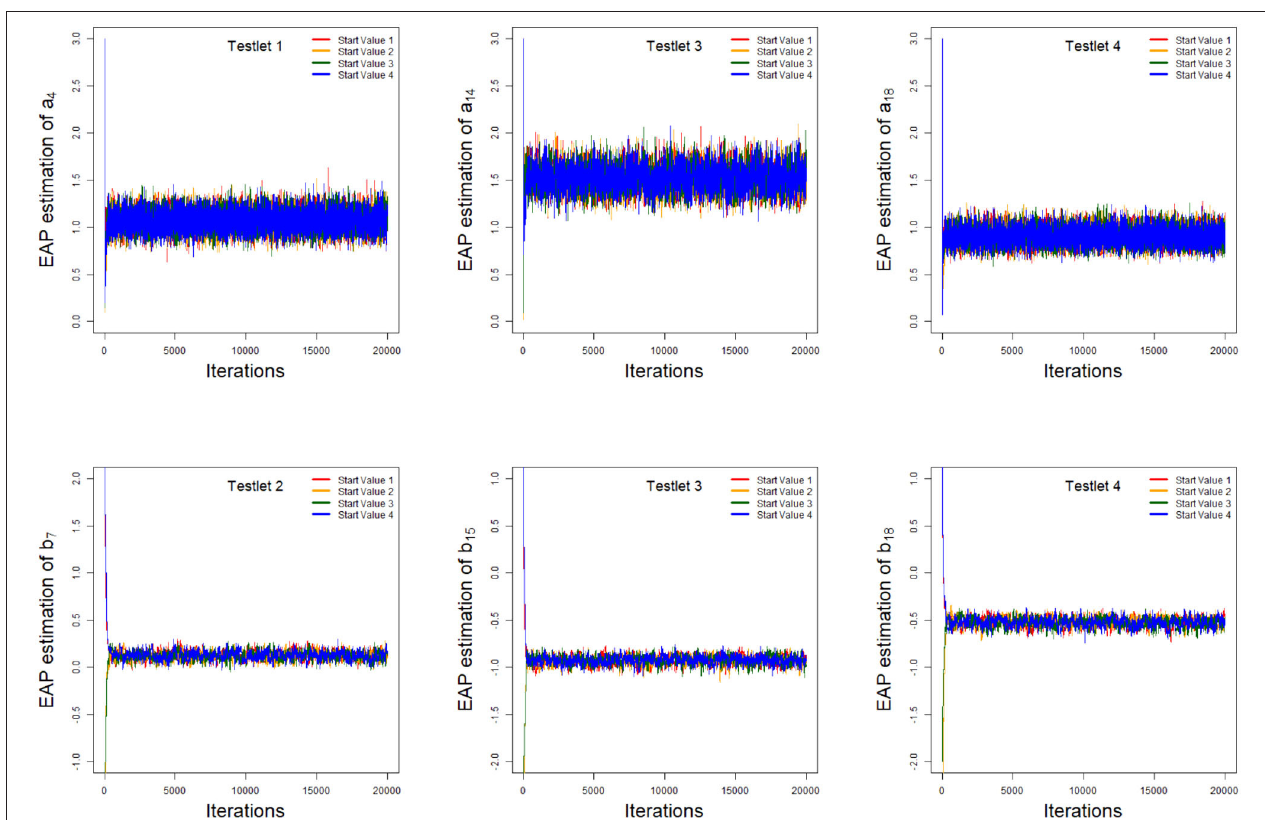
FIGURE 1 | The trace plots of the arbitrarily selected item